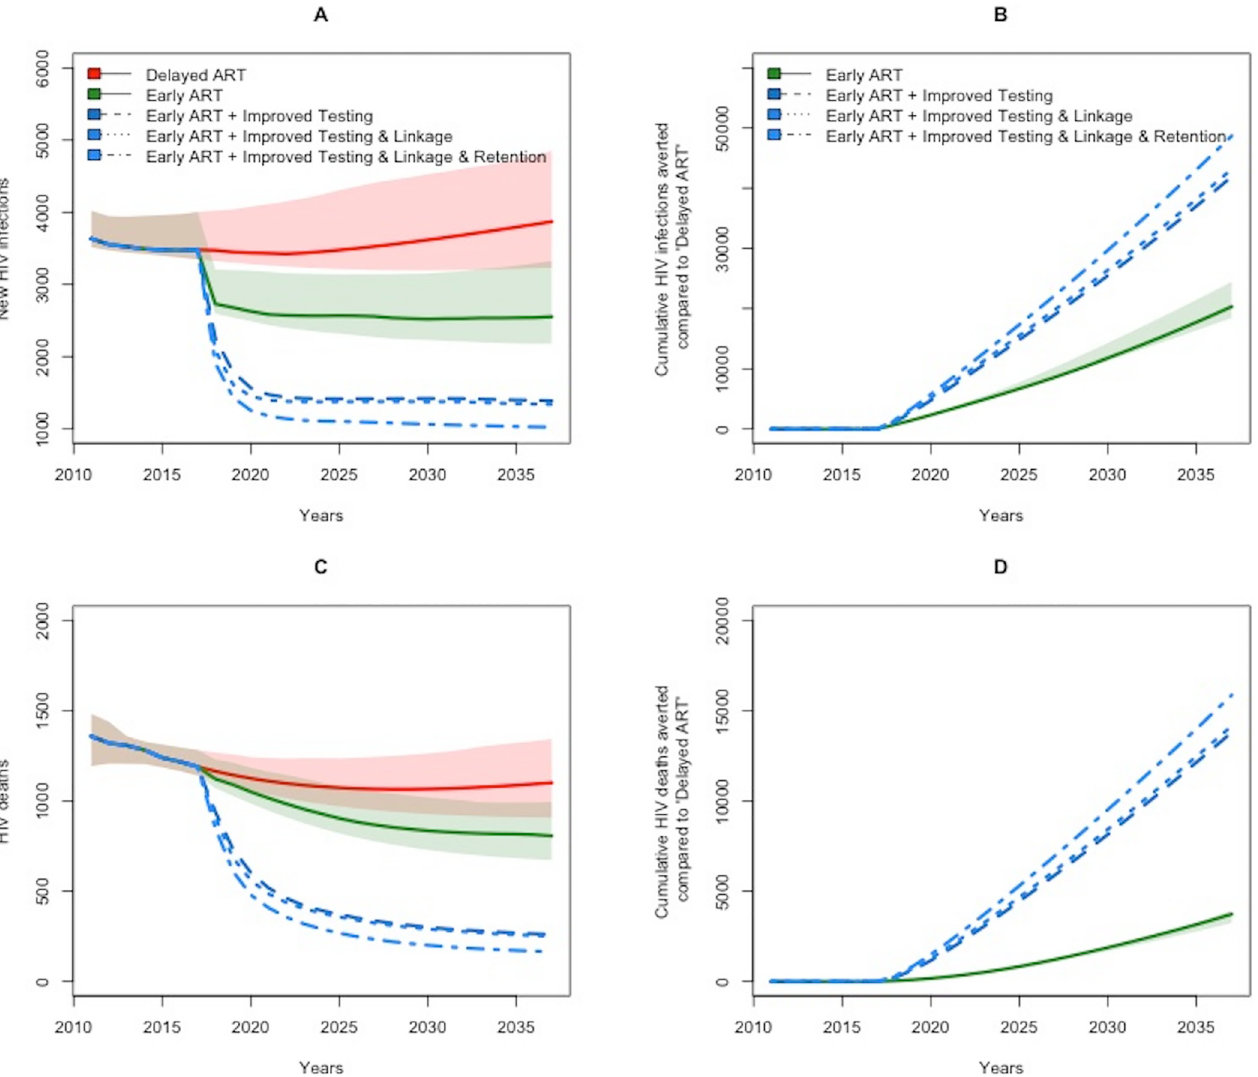
Fig 1. Projected new HIV infections (A), cumulative HIV infections averted (B) HIV deaths (C), and cumulative deaths averted (D) in Spain from 2017 to 2037 under early versus delayed ART. All lines represent the median values of simulations, comparing scenarios representing delayed ART initiation at CD4 counts of < 350 cells/mm 3 (solid red line in Panels A&C) against early ART initiation, both without (solid green line) and with additional improvements to the HIV care continuum (dashed blue lines). The shaded areas represent the corresponding interquartile uncertainty ranges (not shown for the additional improvement scenarios due to